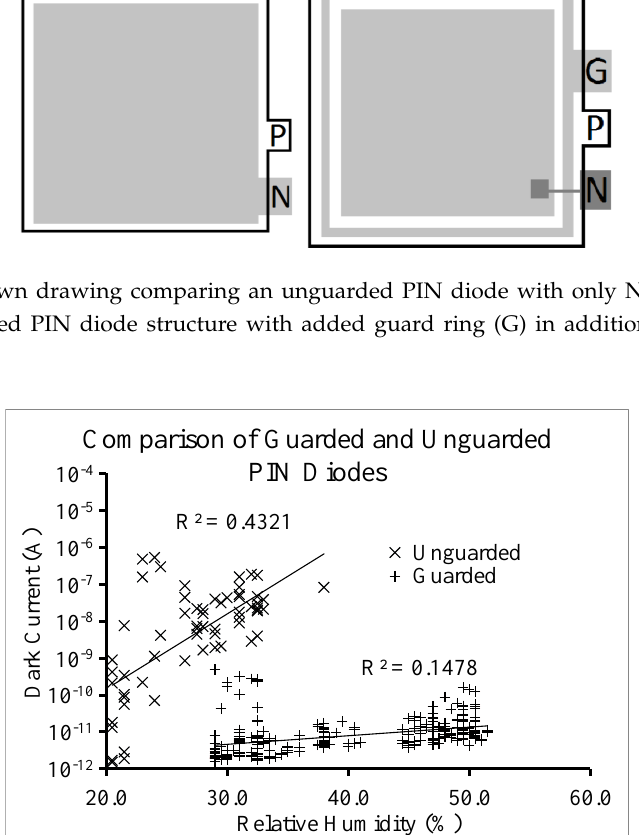
Figure 8. Comparison of the dark current vs. relative humidity for guarded and unguarded PIN diodes.